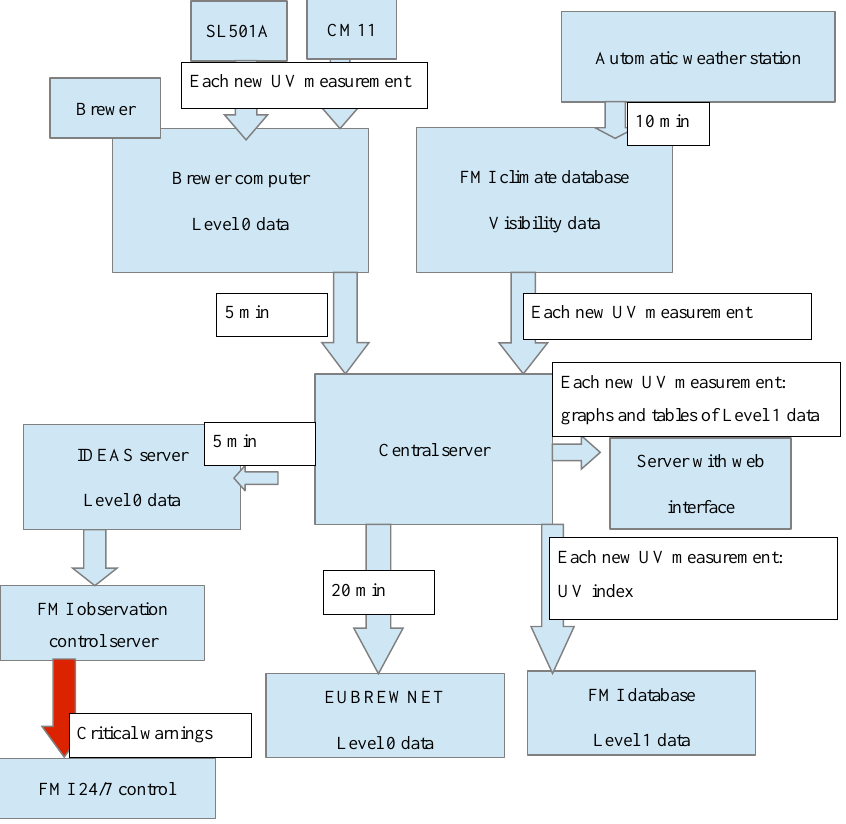
Figure 6. Schematic presentation of Brewer NRT data processing.